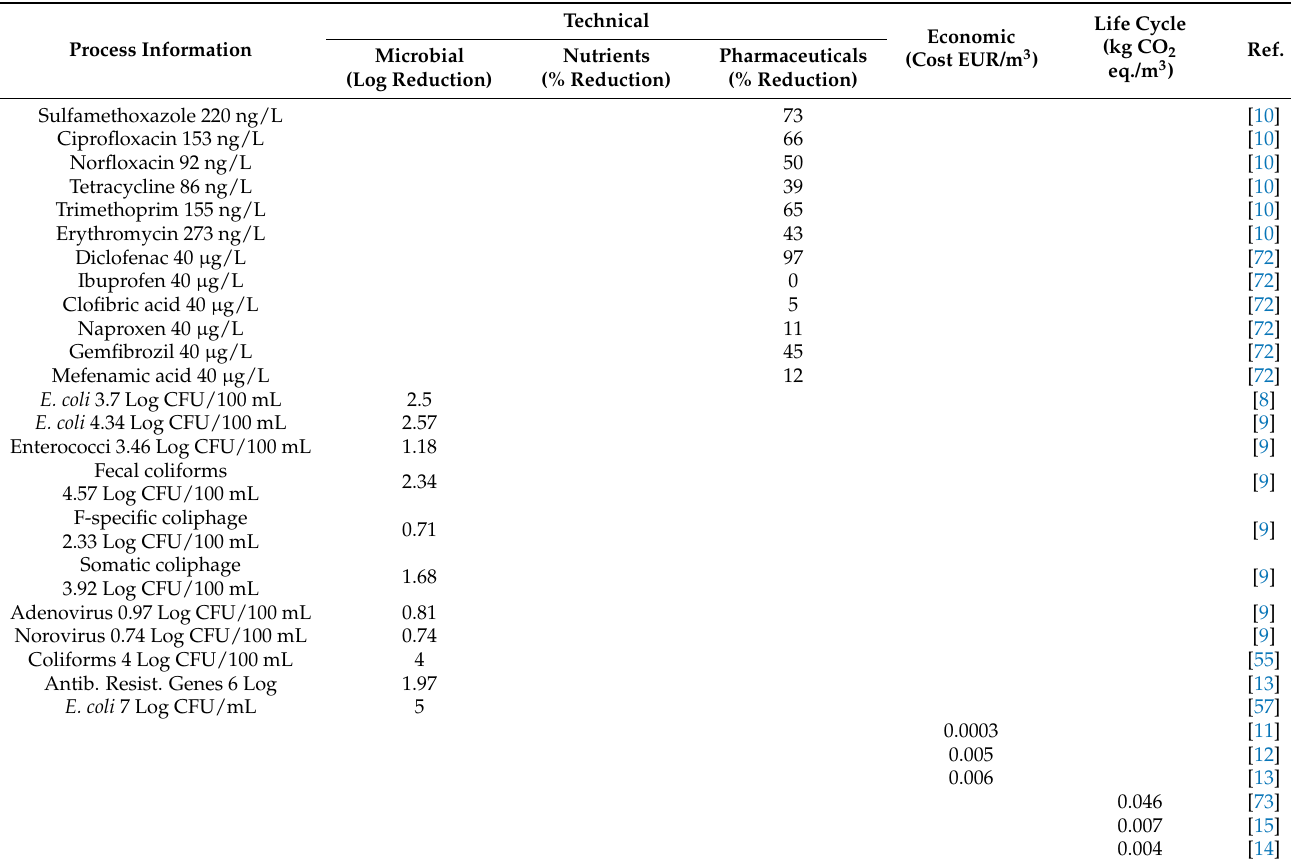
Table A1. Literature data used for scoring the chlorination method.